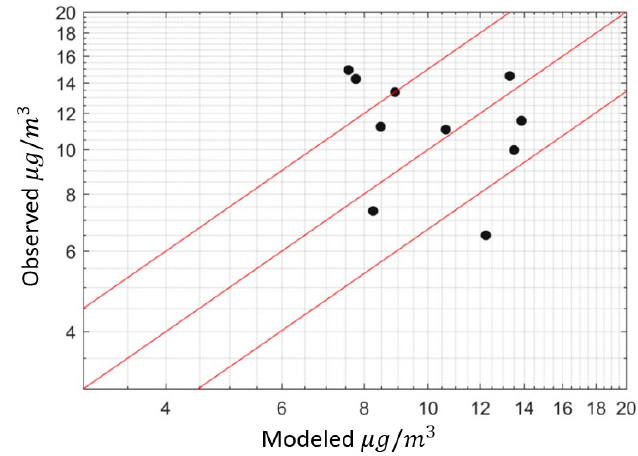
Figure 9. Monthly averaged model concentrations compared to measurements at the Calexico-Ethel St. regulatory station.